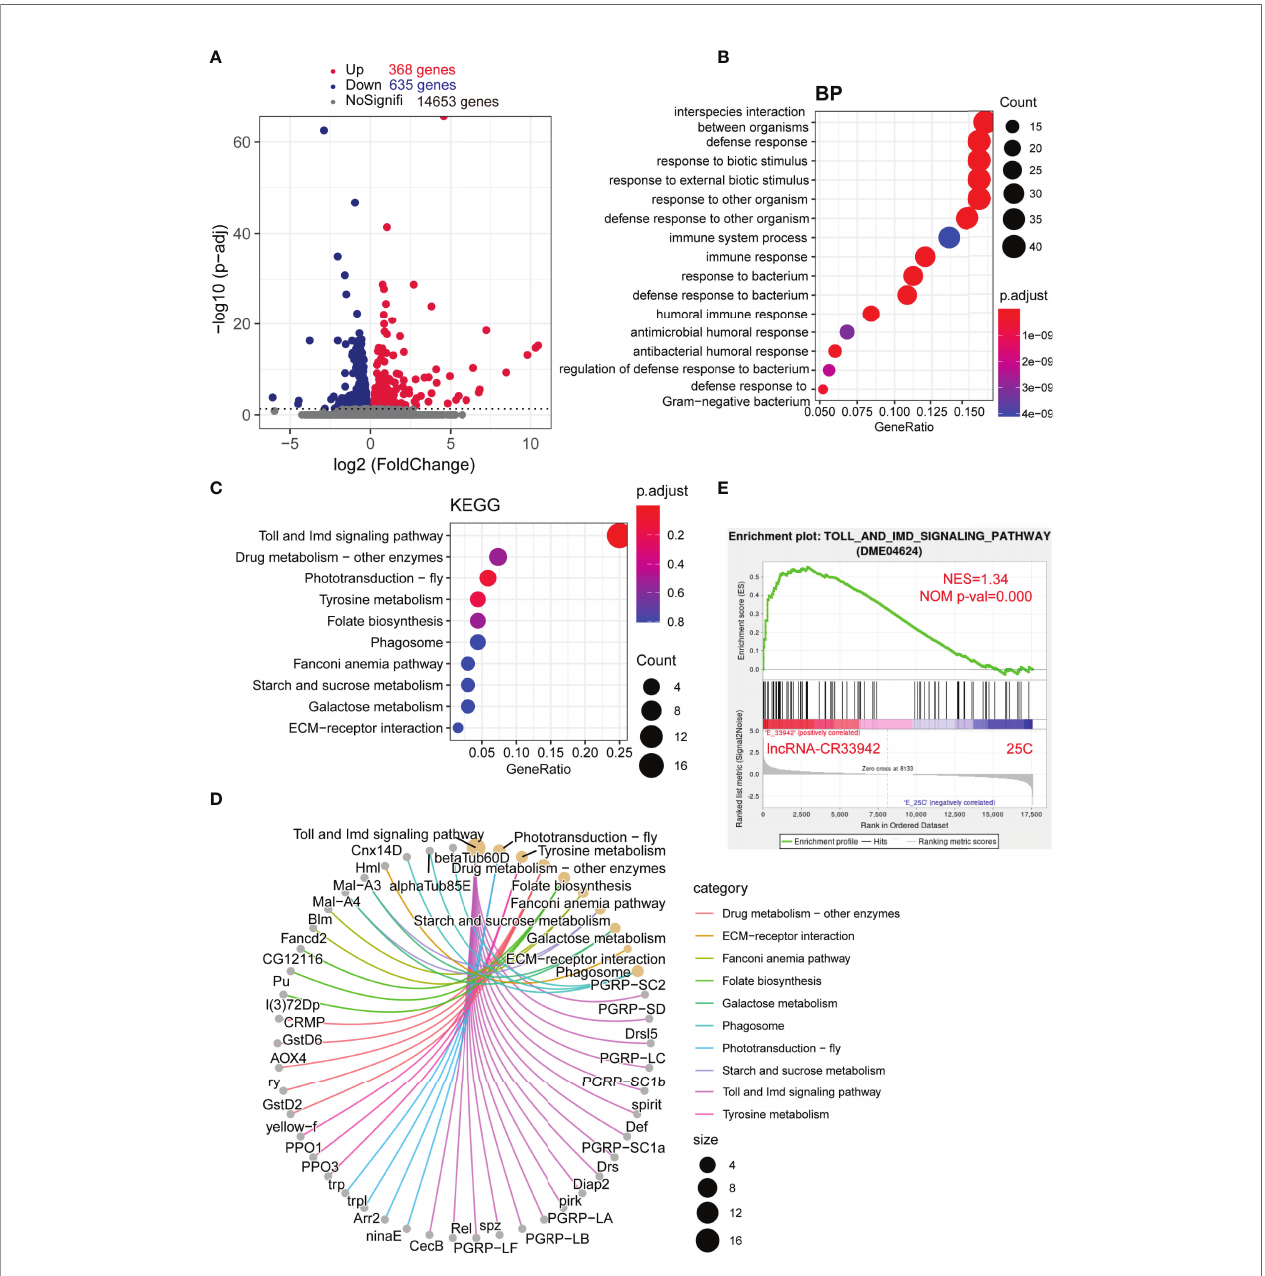
FIGURE 2 | Enrichment analysis of DEGs in the lncRNA-CR33942 -overexpressing fl ies after infection with Escherichia coli . (A) Volcano map shows DEGs between lncRNA-CR33942 -overexpressing and control fl ies after E. coli infection. Red: upregulated DEGs (adjusted P < 0.05); blue: downregulated DEGs (adjusted P < 0.05). (B) Bubble chart shows biological process (BP) enrichment analysis of upregulated DEGs. (C) Bubble chart shows the KEGG pathway enrichment analysis of upregulated DEGs. (D) Network chart displays the KEGG pathway enrichment analysis and corresponding upregulated DEGs. (E) GSEA of the RNA-seq data between the lncRNA-CR33942 -overexpressing and control fl